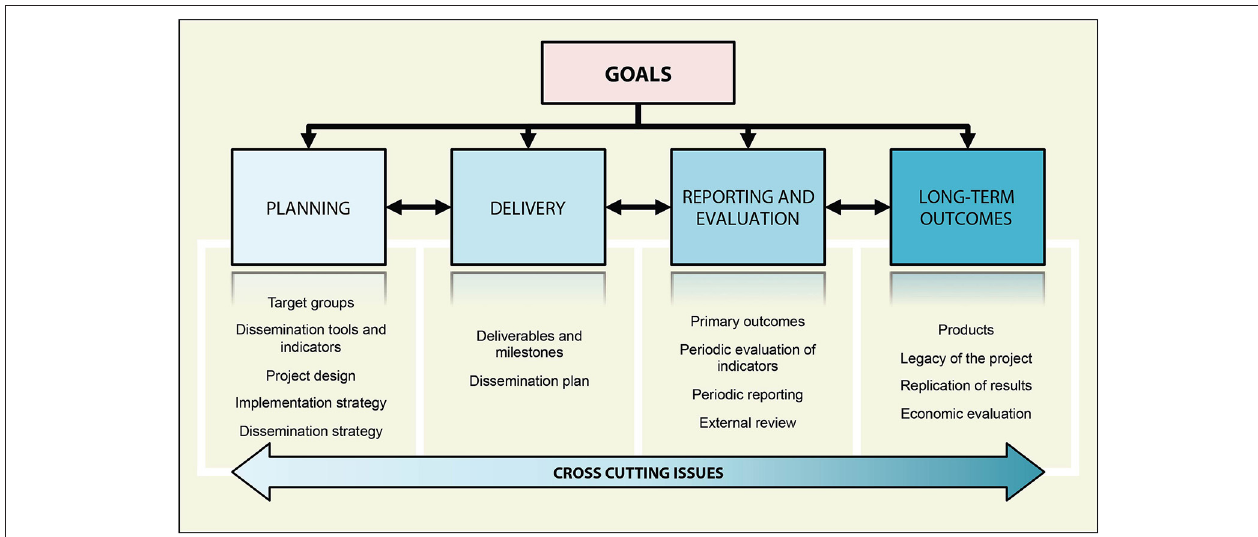
FIGURE 2 | Framework for enhancing the value of DEVOTES research for dissemination and implementation (inspired and adapted from Neta et al., 2015).